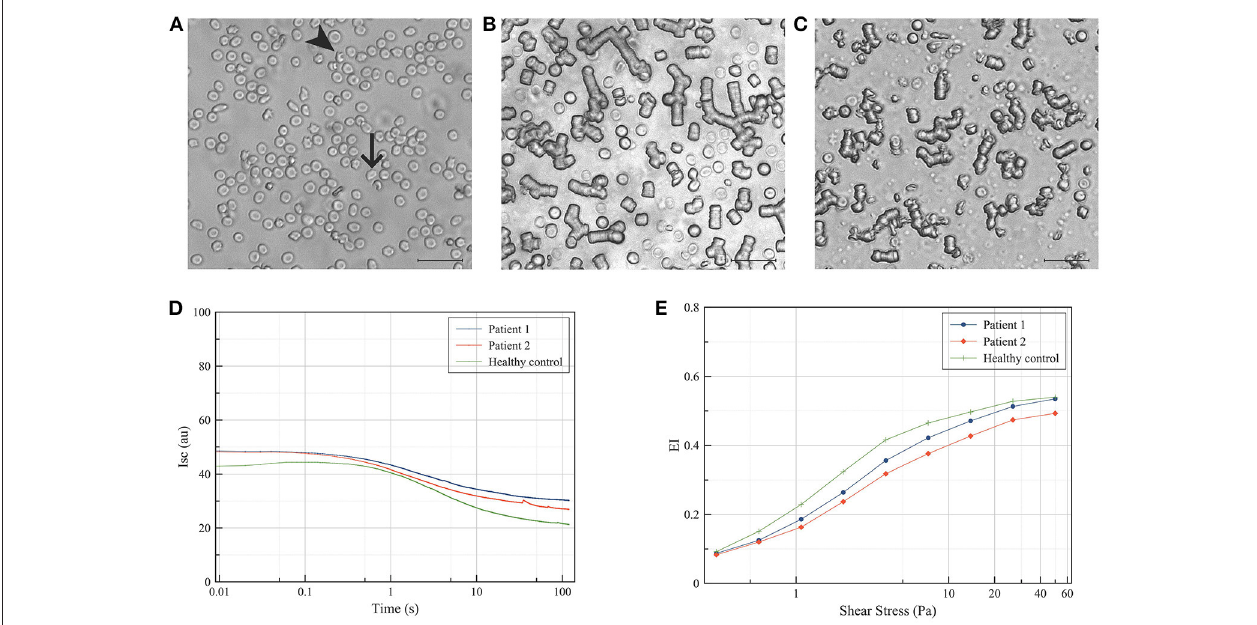
FIGURE 1 | Deformability and aggregation of red blood cells from patients with neuroacanthocytosis. Red blood cells were isolated from patients with neuroacanthocytosis as described before (16), and their morphology, aggregation and deformability were compared with those of a healthy control donor. ( A) Bright-field microscopy of the red blood cells of one patient (0.1% hematocrit in phosphate-buffered saline), showing acanthocytes (arrowhead) and otherwise misshapen red blood cells (arrow); ( B) Bright-field microscopy of the red blood cells of a healthy control donor (1% hematocrit in plasma), showing aggregates mostly as rouleaux after 2 to 3min of incubation at room temperature; ( C) Bright-field microscopy of red blood cells of an acanthocytosis patient showing smaller rouleaux and much more disordered aggregates; ( D) Syllectograms of the red blood cells of a healthy control donor and two neuroacanthocytosis patients obtained in 40% hematocrit in plasma, showing altered aggregation characteristics of the patients’ red blood cells; ( E) Deformability curves of the red blood cells of one healthy control and two neuroacanthocytosis patients, showing a lower maximum elongation index (EI) in the patients’ red blood cells. Aggregation and deformability were measured using a Lorrca (RR Mechatronics, Hoorn, The Netherlands) as described before (12, 27).